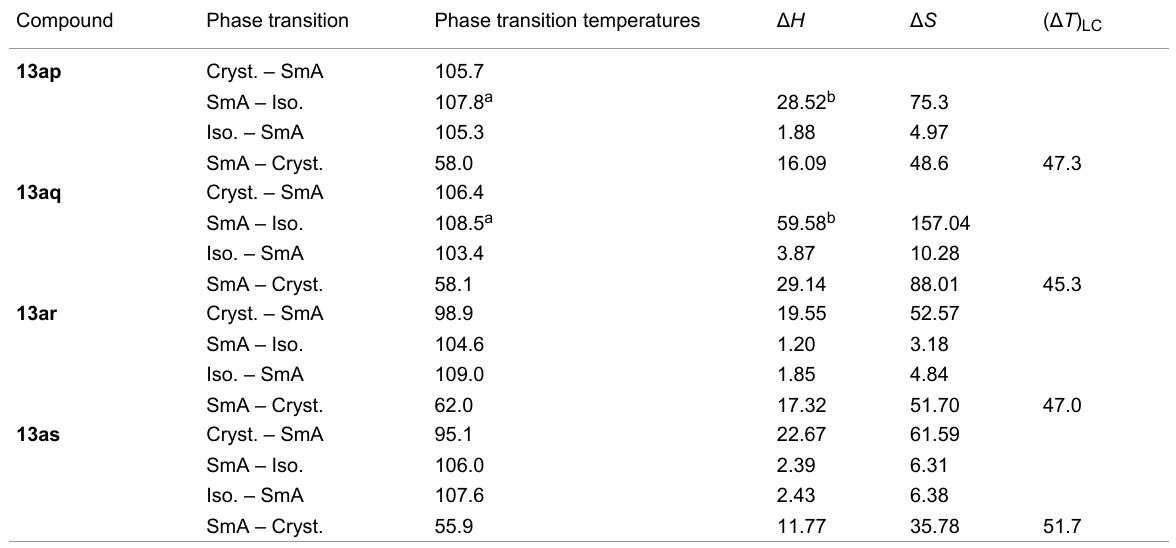
a Not well resolved, b combined enthalpy change.